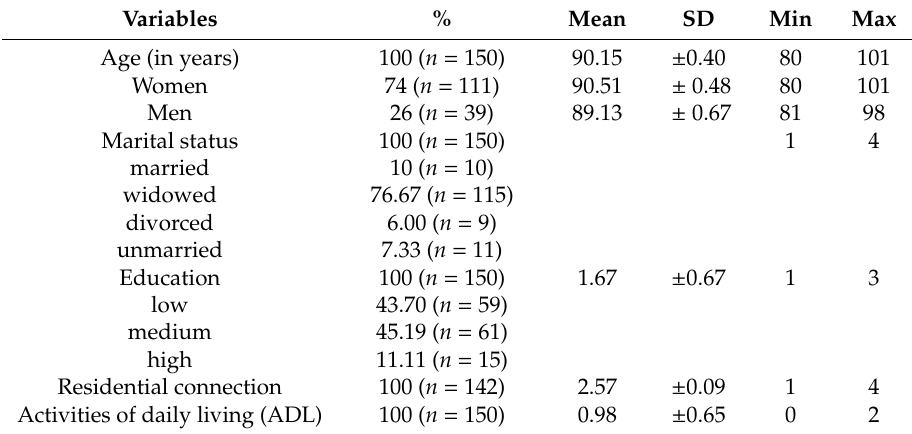
Table 1. Descriptive characteristics of study